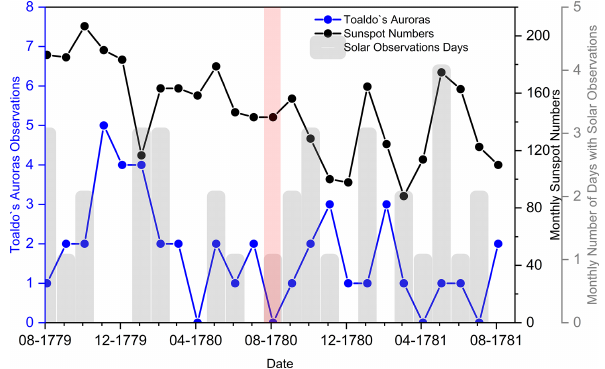
Figure 4. Monthly sunspot numbers, days with solar observations and auroras from Toaldo’s catalogue from August 1779 to Au- gust